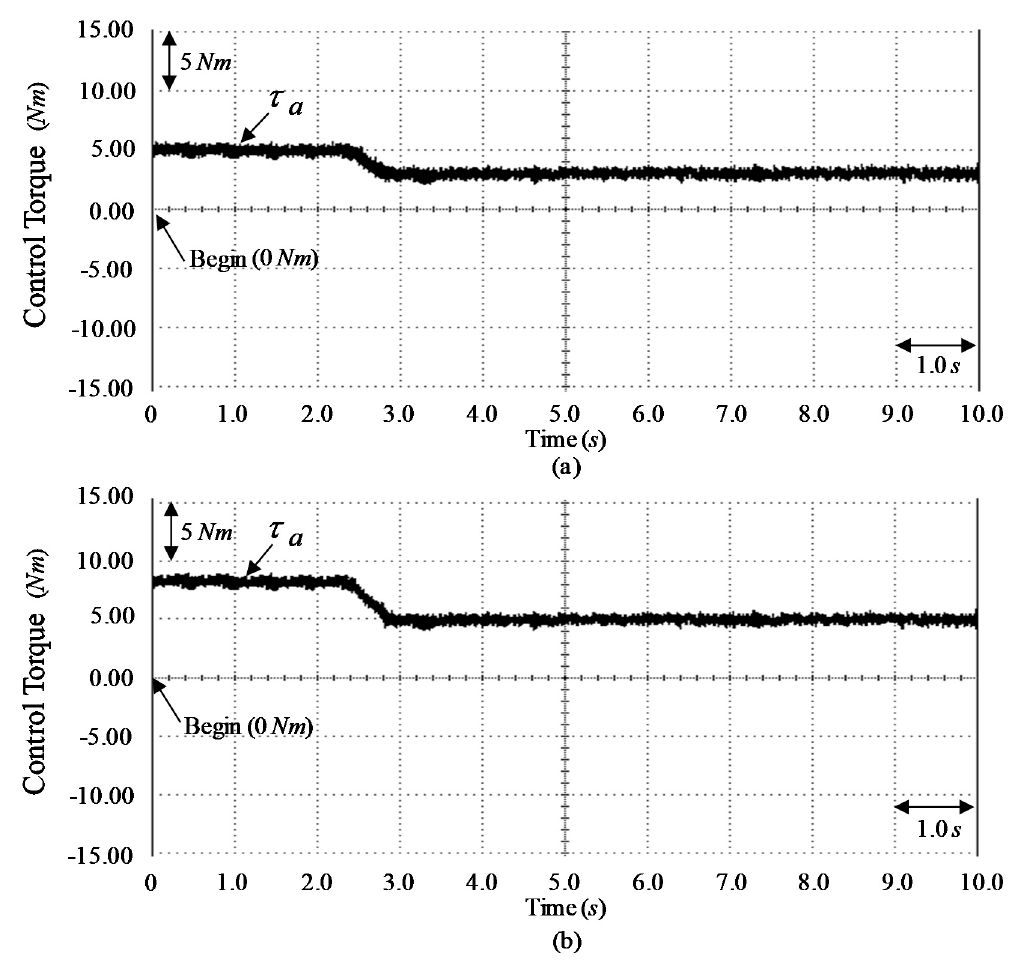
Figure 8. Tested results for the SIM expelling CVT organized system by using the controller CT1: ( a ) response of developed torque at the tested Event E1 case, ( b ) response of developed torque at the tested Event E2 case.